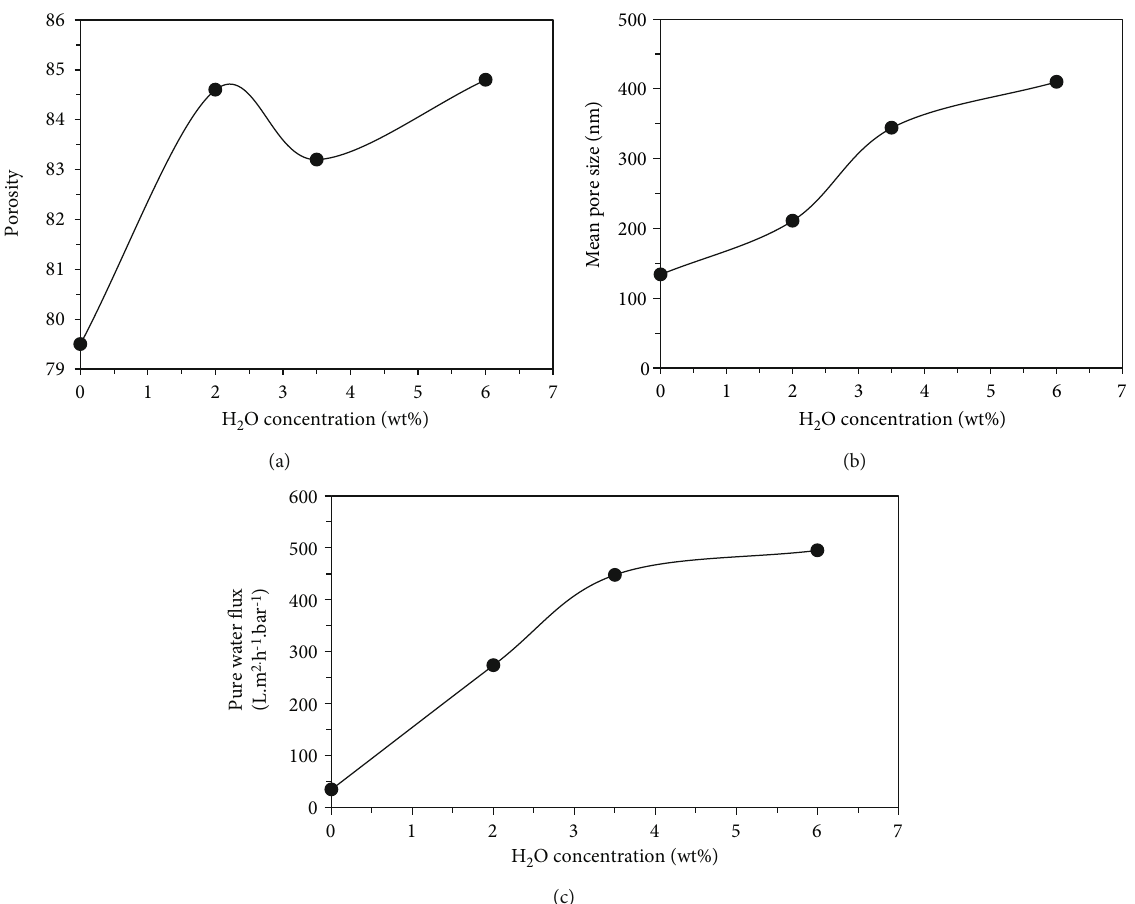
Figure 5: E ff ect of H O nonsolvent concentration on the membrane porosity (a), mean pore size (b), and pure water fl ux (c) of PAN hollow 2 fi ber membranes.